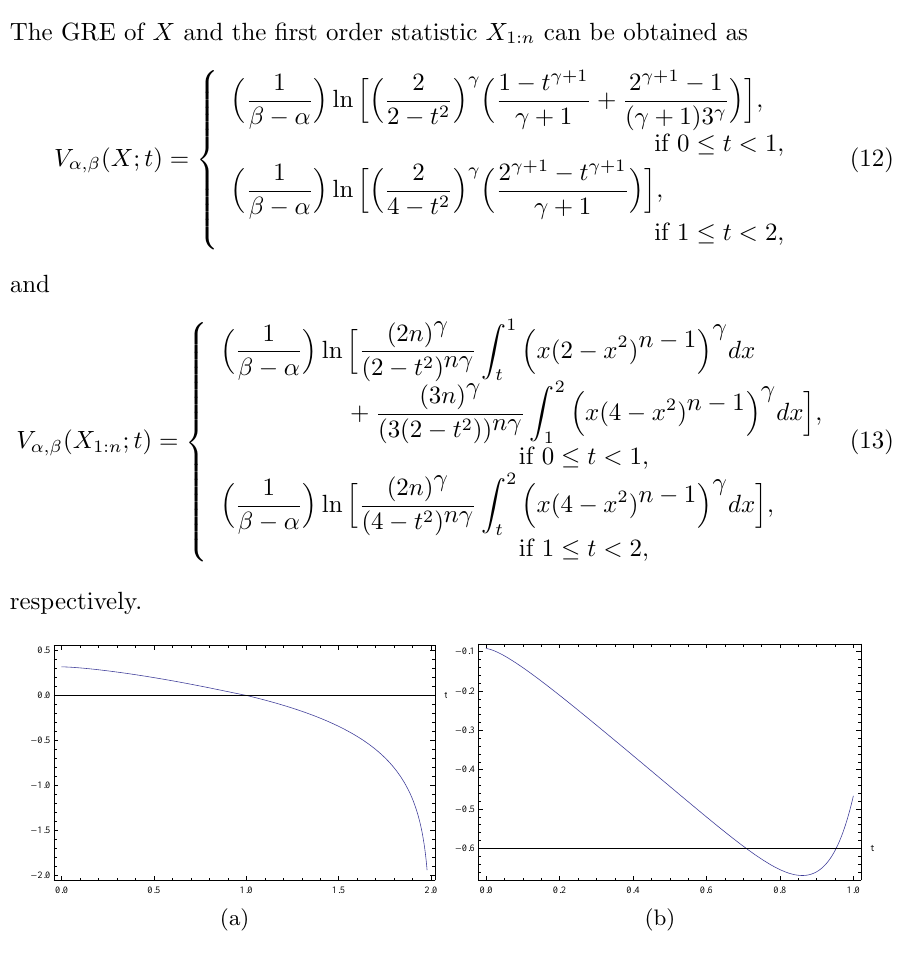
Figure 3 { (a) V 0 : 4 ; 1 : 2 ( X ; t ) Vs t; (b) V 0 : 4 ; 1 : 2 ( X 1: n ; t ) Vs t when n = 10